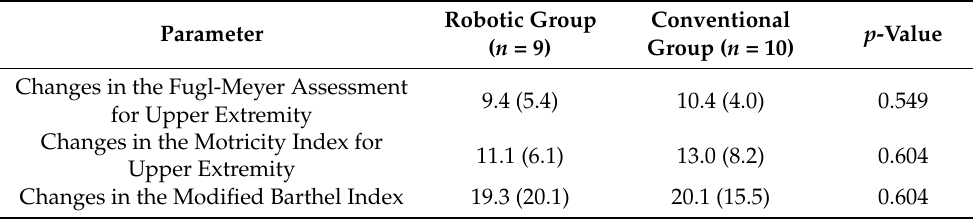
Table 3. Changes in clinical scales in the two treatment groups, together with the statistical analysis.